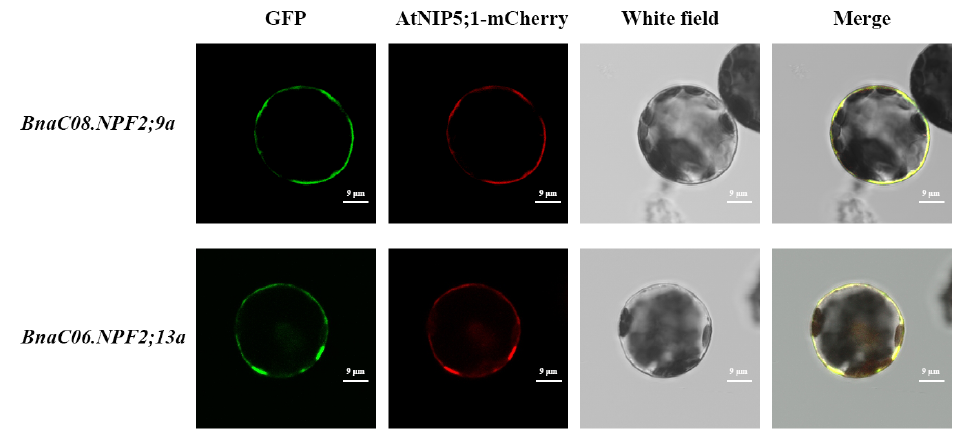
Figure 9. Subcellular localization of BnaC08.NPF2;9a and BnaC06.NPF2;13a. 35S :: BnaNPFs - GFP and 35S :: AtNIP5;1 - mCherry constructs were introduced into Arabidopsis protoplasts. The GFP and mChery fluorescence was observed with a confocal laser-scanning microscope. The images were taken in the dark and white field.